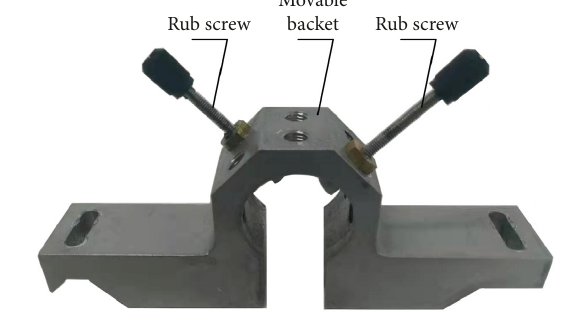
Figure 6: Rub-impact